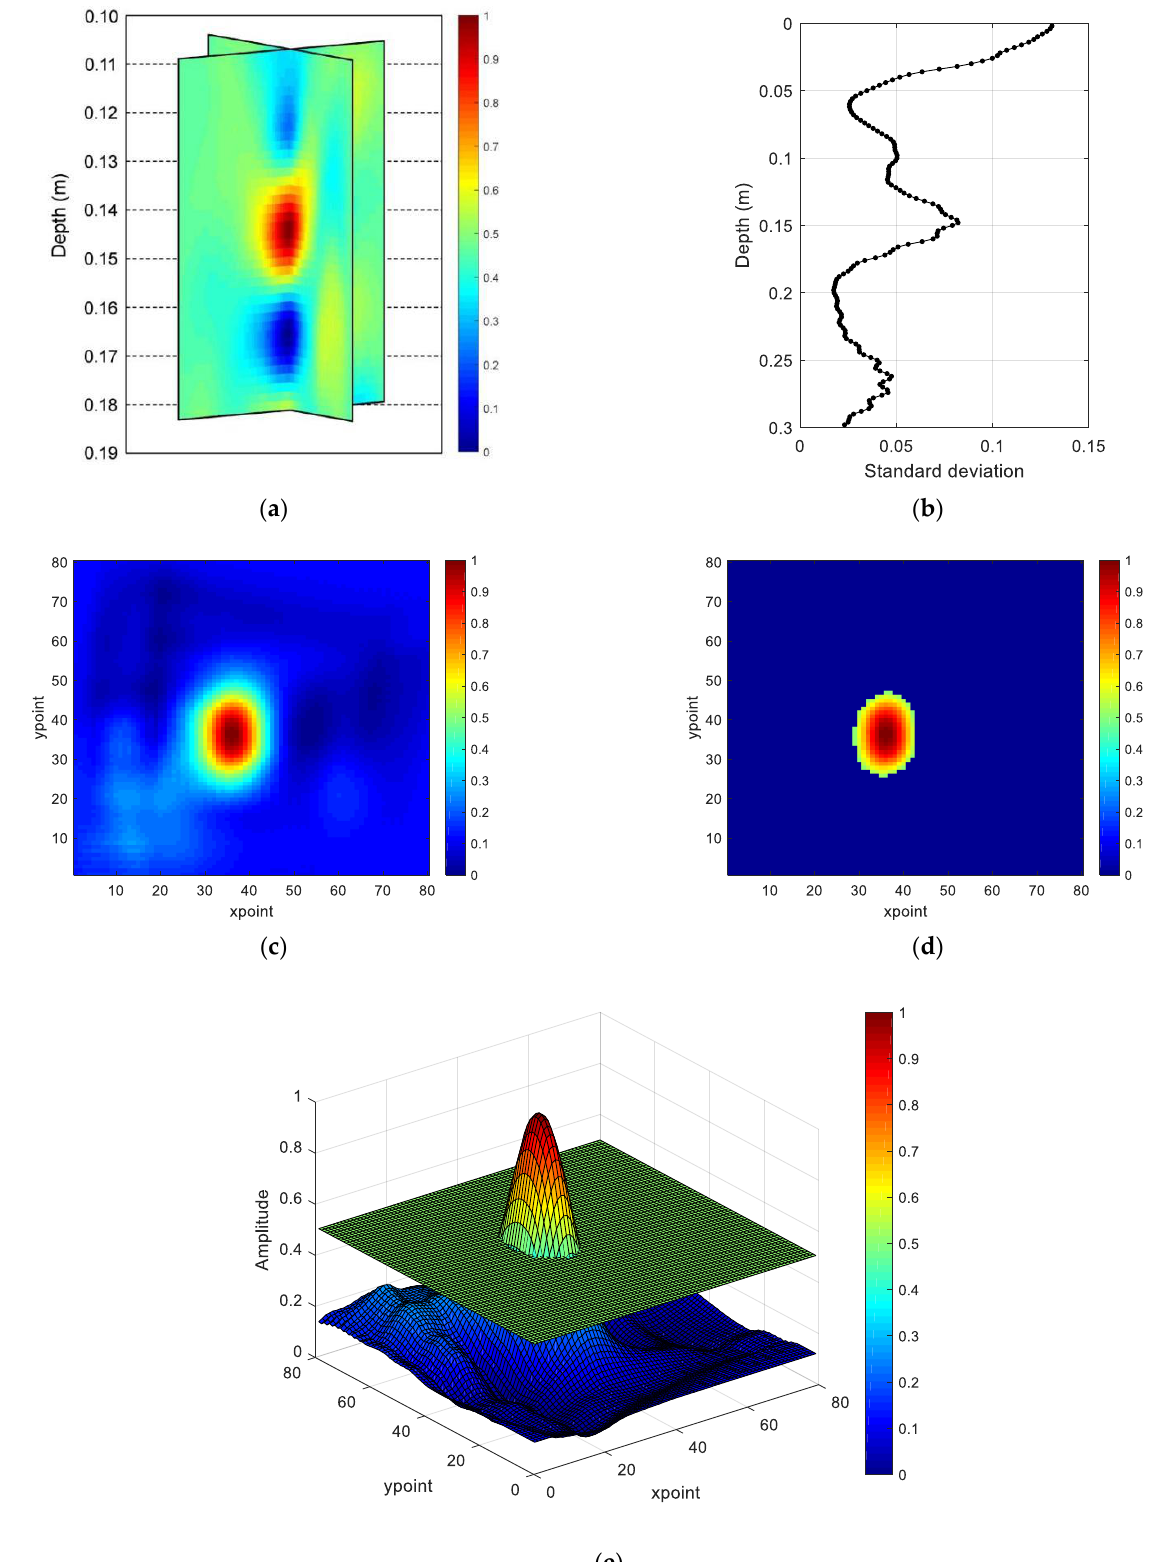
Figure 4. Signal processing results at the velocity of 0.15596 m/ns. ( a ) Vertical slices of the migrated GPR data. ( b ) The standard deviation of cross-correlation. ( c ) Depth slice containing the target. ( d ) Pixels in the migration image slice with values greater than a certain threshold. ( e ) Depth slice containing the target with the threshold plane ( ε =